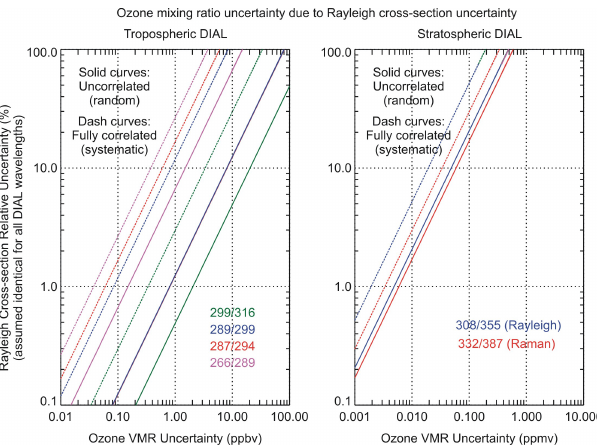
Figure 8. Ozone mixing ratio uncertainty as a function of Rayleigh cross section relative uncertainty (%), assuming that all cross sec- tions used have the same relative uncertainty. Solid curves are used for cases of independent (random) cross section datasets, and dashed curves are used for the case of full correlation between all cross